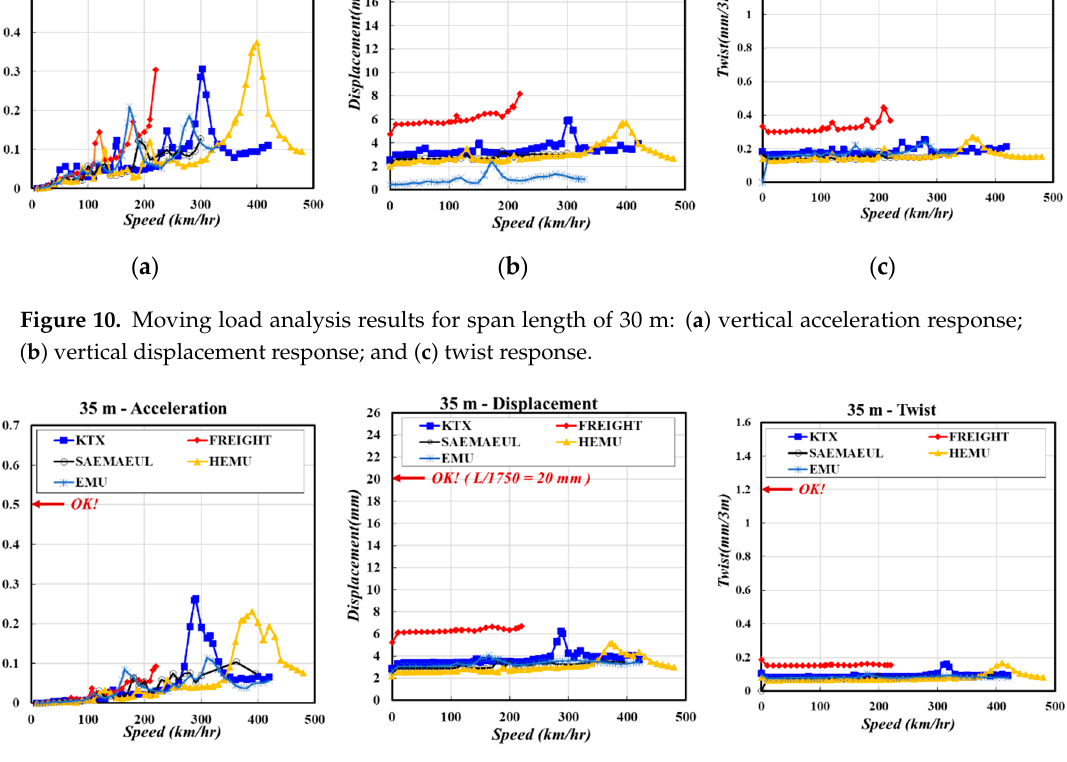
Figure 11. Moving load analysis results for span length of 35 m: ( a ) vertical acceleration response; ( b ) vertical displacement response; and ( c ) twist response.